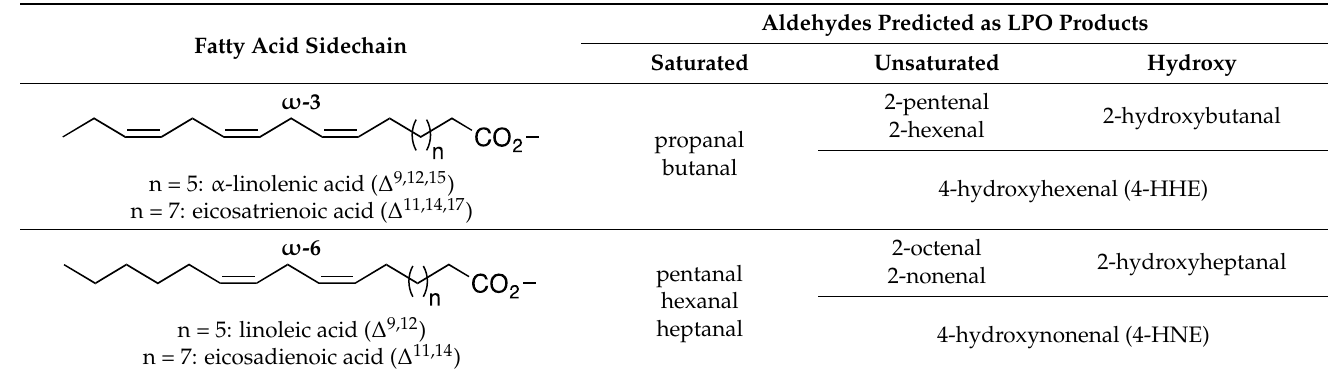
Figure 3. Bis-peroxidation pathways leading to the formation of 2- and 4-hydroxyaldehydes. At- oms in red give rise to the aldehydes generated by the indicated processes. Table 2. Predicted LPO-derived aldehydes from a selection of unsaturated fatty acyl chains present ω ω in common -3 to -9 lung phosphatides.